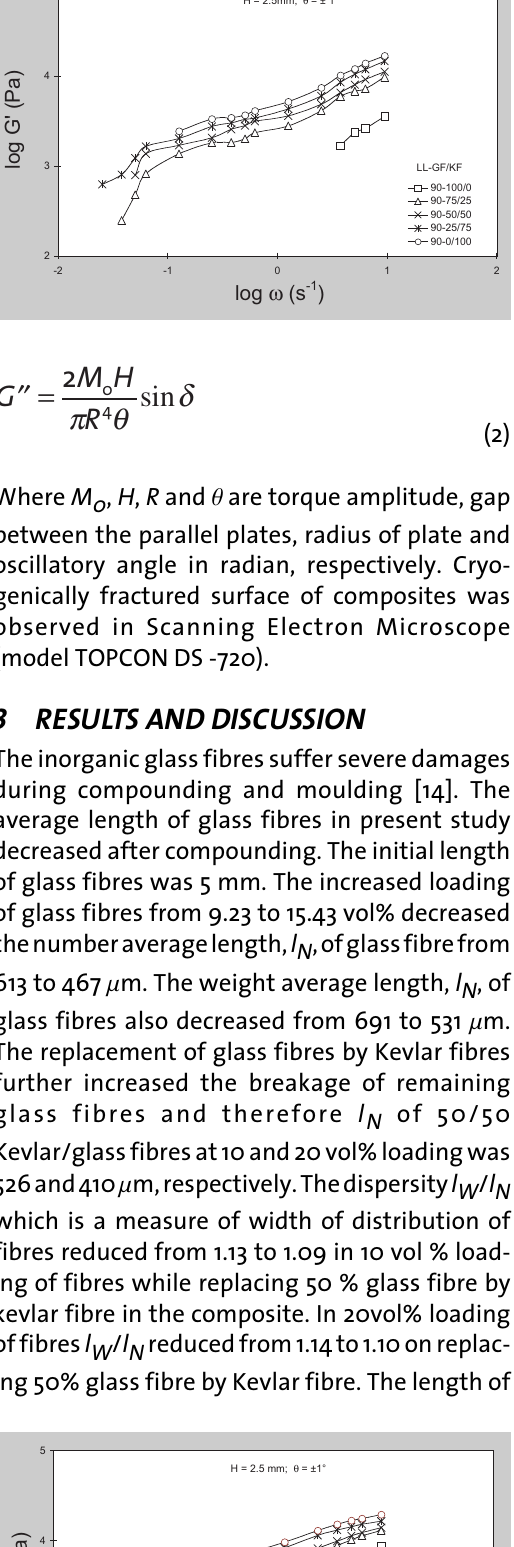
Figure 3 (left): Loss modu- lus, G’’, as a function of angular frequency, w , for LLDPE and 10 vol% fibre reinforced LLDPE. Figure 4 (right): Loss modulus, G’’, as a func- tion of angular frequency, w , for LLDPE and 20 vol% fibre reinforced